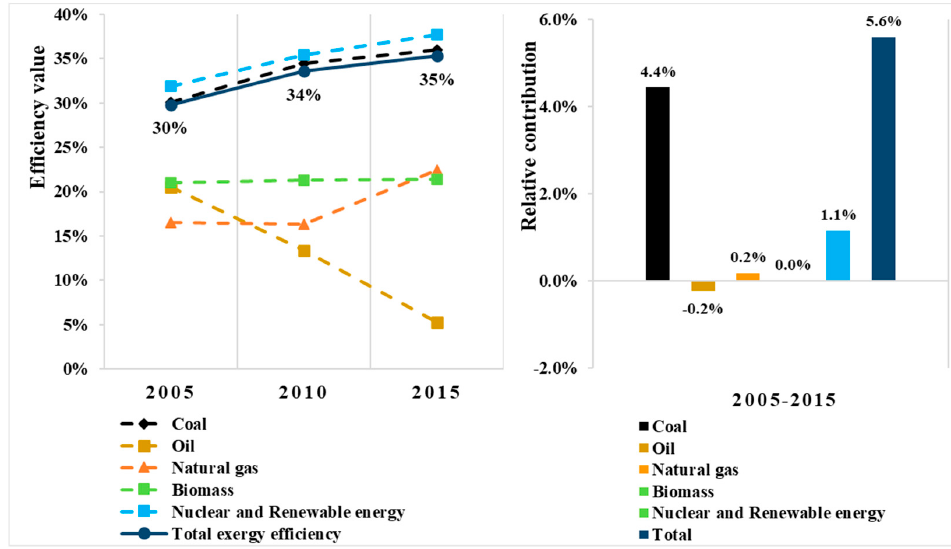
Figure 9. The efficiency of different power and heat generation sub-sectors in China from 2005 to 2015 (Left); Relative contributions of efficiency improvements in the power and heat generation sector in China from 2005 to 2015 (Right).